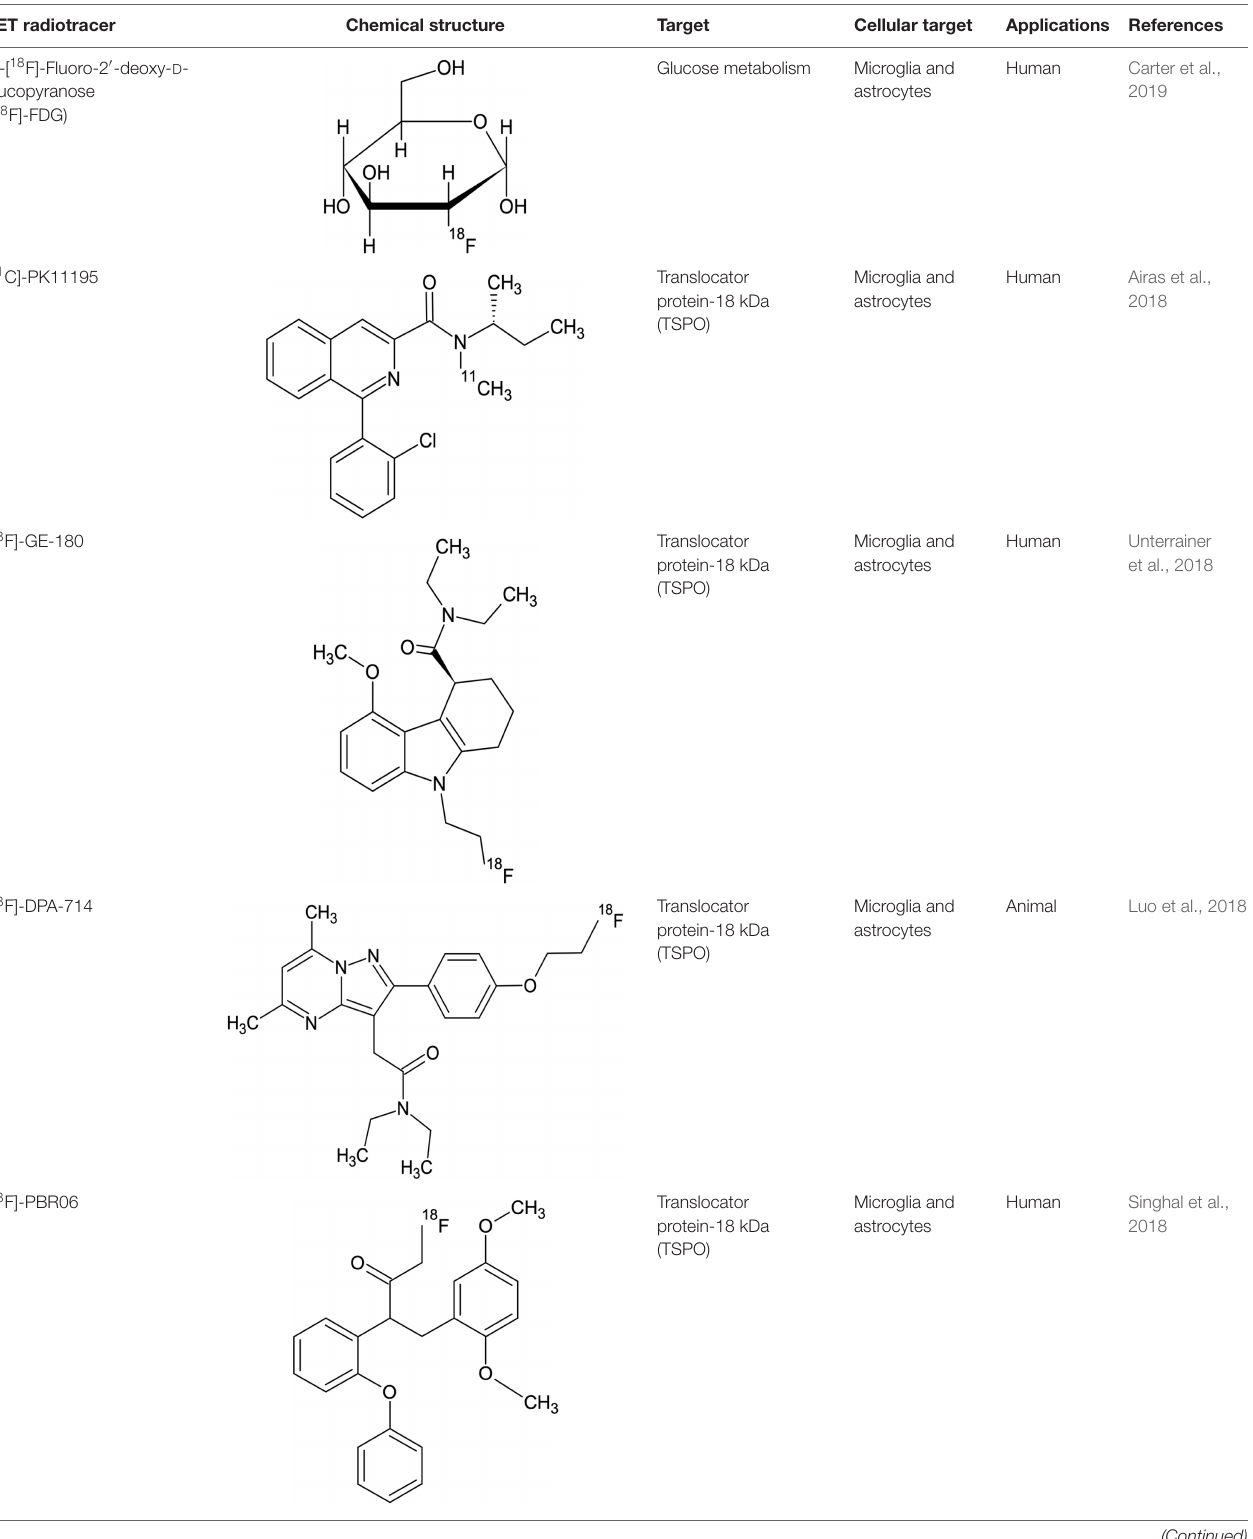
TABLE 1 | Main PET radiotracers used to investigate selective microglial and astrocytic